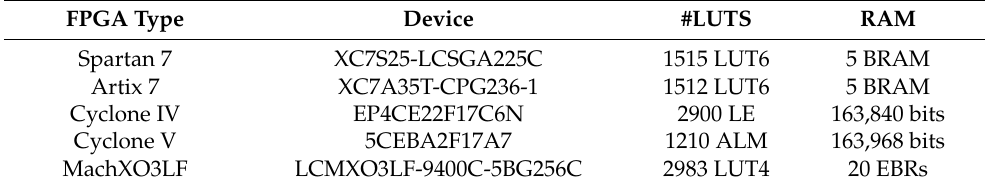
Table 3. Minimal Dracon implementation results (25-MHz